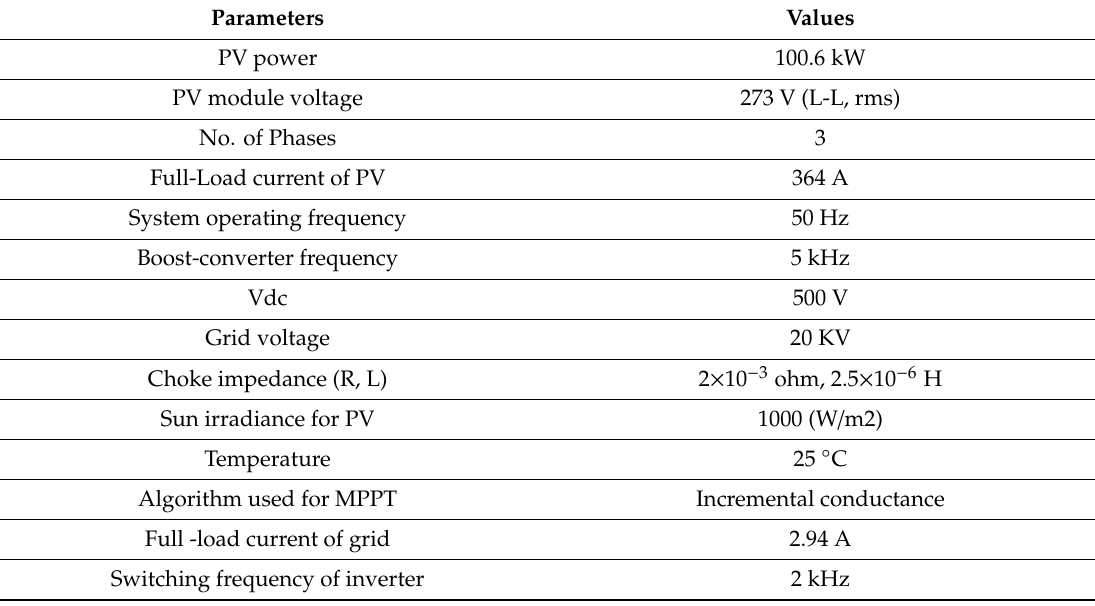
Table A1. Model rated parameters.